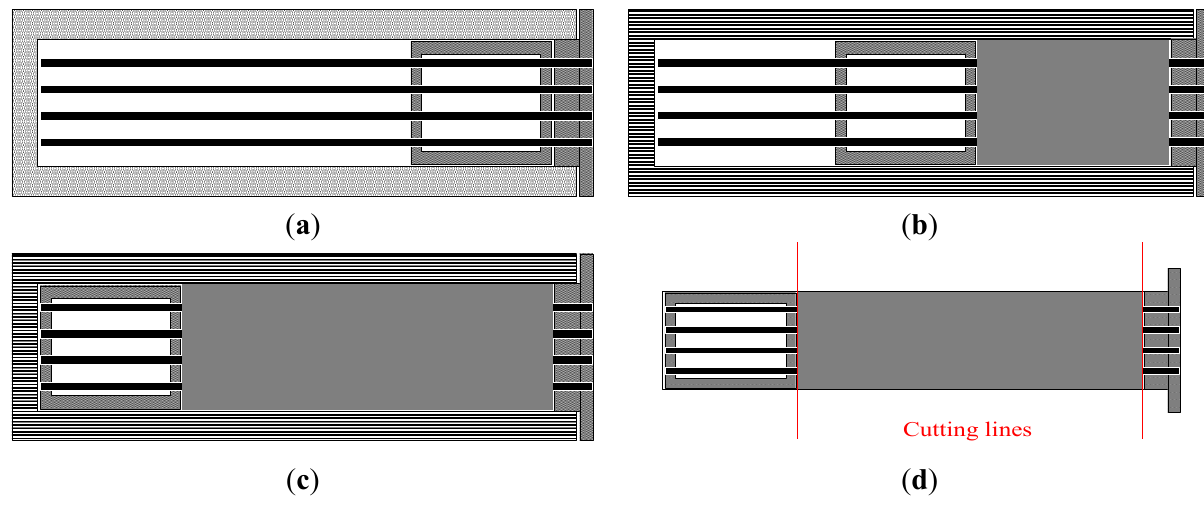
Figure 4. Scheme of the in mold extrusion process with selective reinforcement.